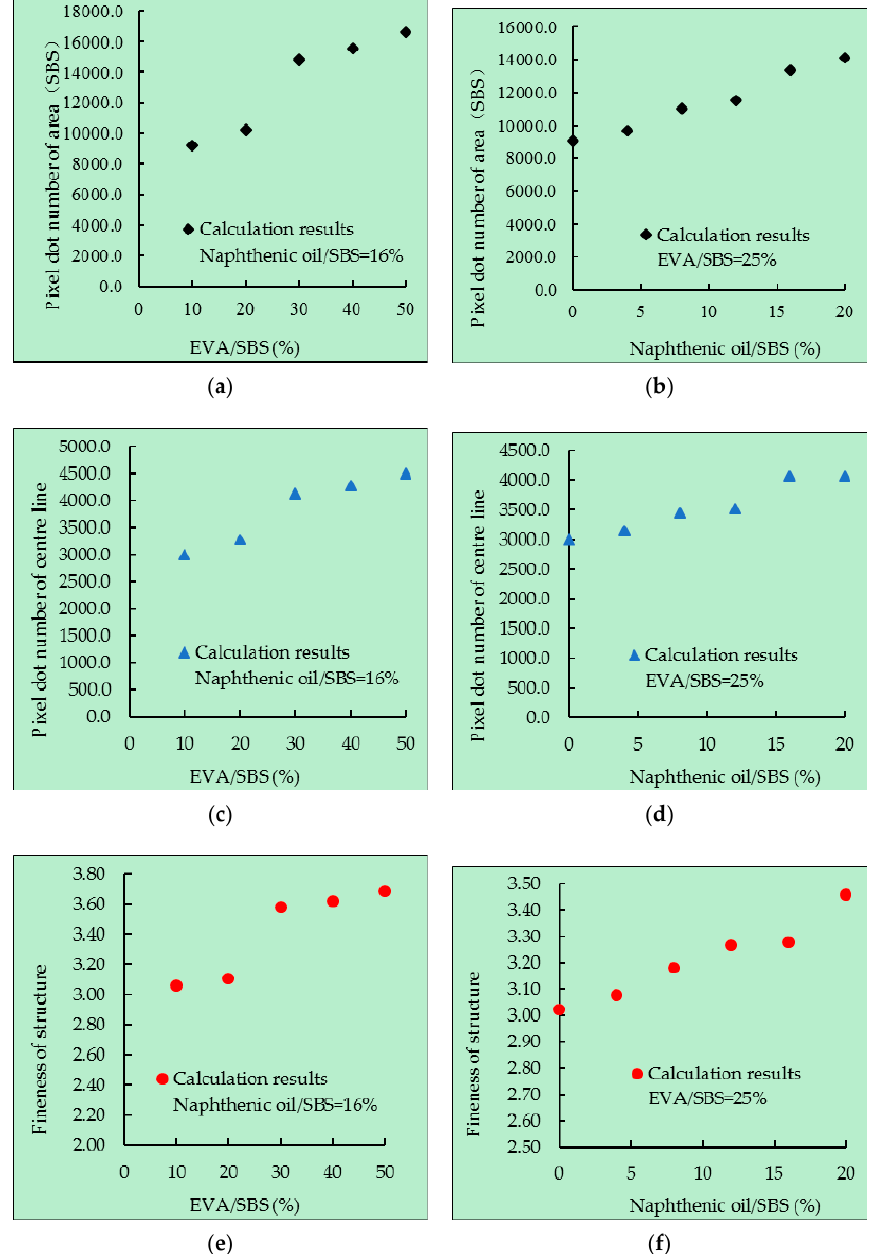
Figure 8. The relation between components of direct-to-plant SBS and microstructure parameters, when naphthenic oil / SBS = 16%: ( a ) pixel dot number of area (SBS), ( c ) pixel dot number of centre line (SBS) and ( e ) fineness of structure. When EVA / SBS = 25%: ( b ) pixel dot number of area (SBS), ( d ) pixel dot number of centre line (SBS) and ( f ) fineness of structure.